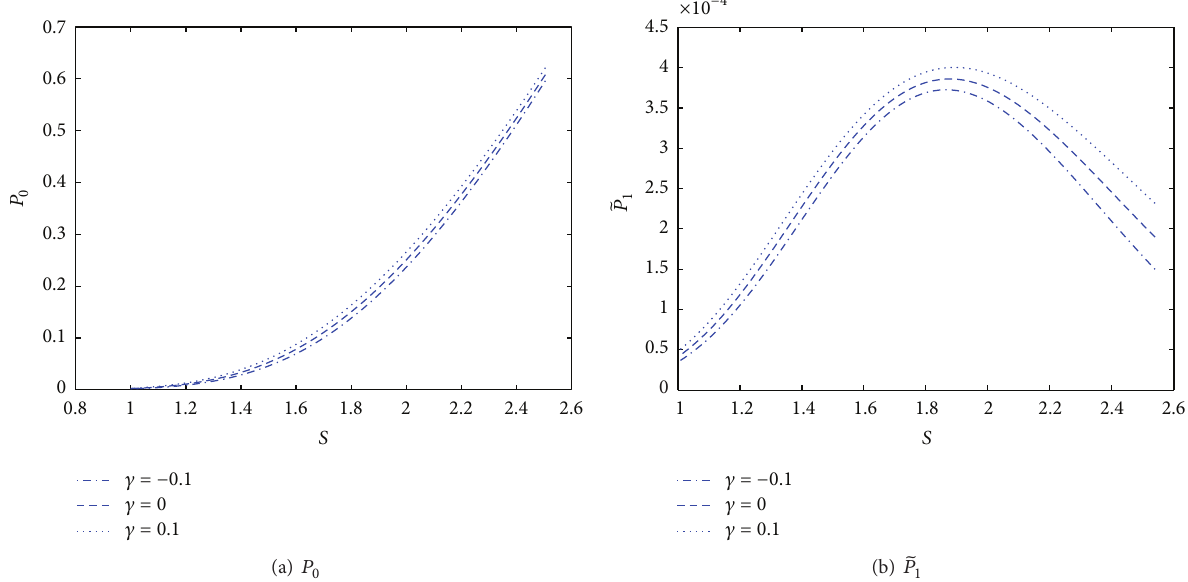
̃𝑃 1 of the price of an arithmetic average Asian option are drawn for